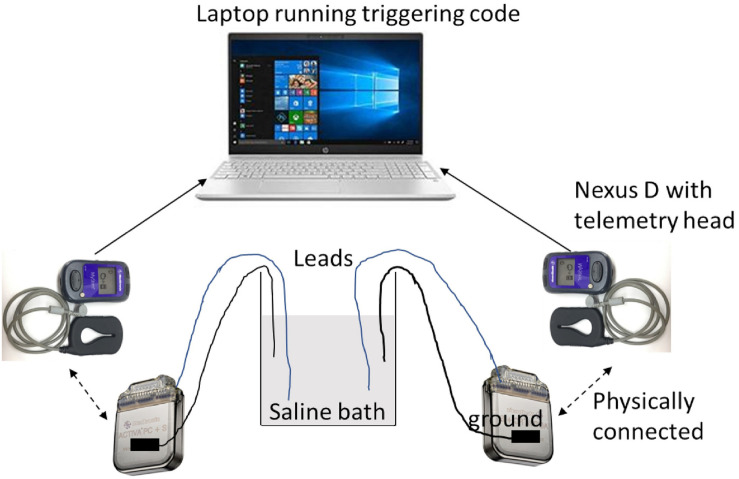
Schematic of saline bath preparation.